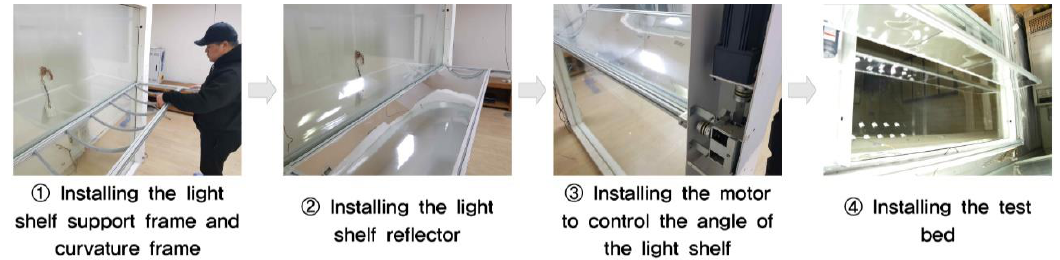
Figure 7. Fabrication and installation of a curved light shelf for performance evaluation.